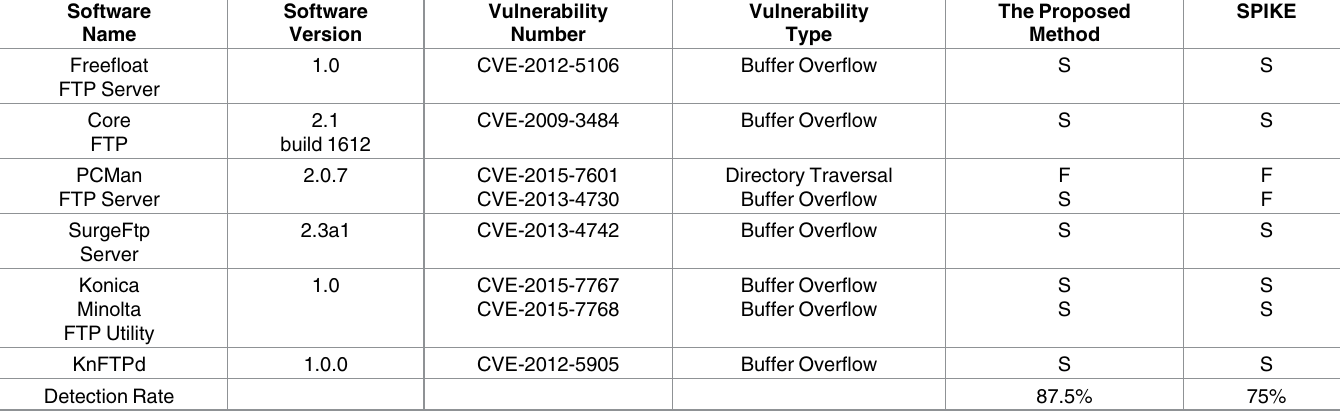
Table 4. Comparison of the proposed method and SPIKE in vulnerability detection using applications running the FTP protocol(S: Success, F: Failure). Software